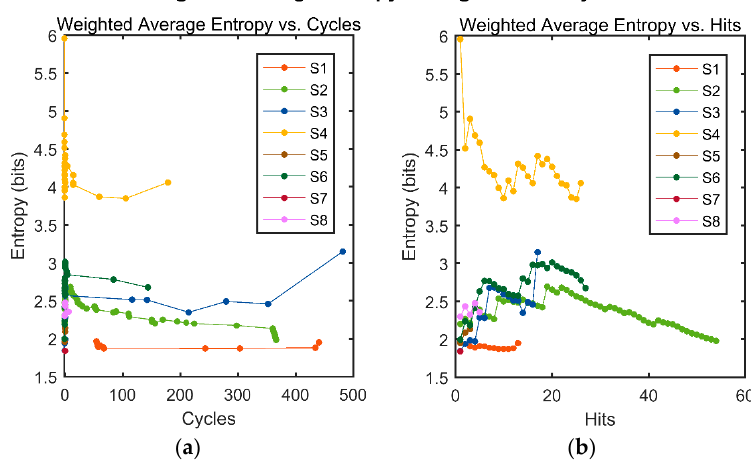
Figure 12. Weighted average entropy trends versus fatigue cycles and hit count over the first 500 cycles: ( a ) weighted average entropy versus cycles; and ( b ) weighted average entropy versus hits.